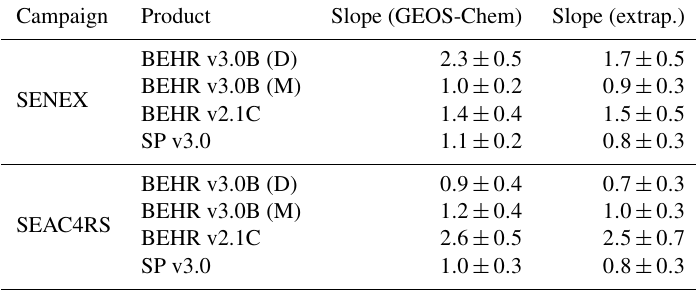
Table 4. Slopes and 1 σ uncertainties for reduced major axis (RMA) regression of satellite VCDs against in situ calculated VCDs. Both methods of extending the profiles (using GEOS-Chem modeled profiles or extrapolating the top and bottom 10 points) are included. Outliers are removed before calculating these